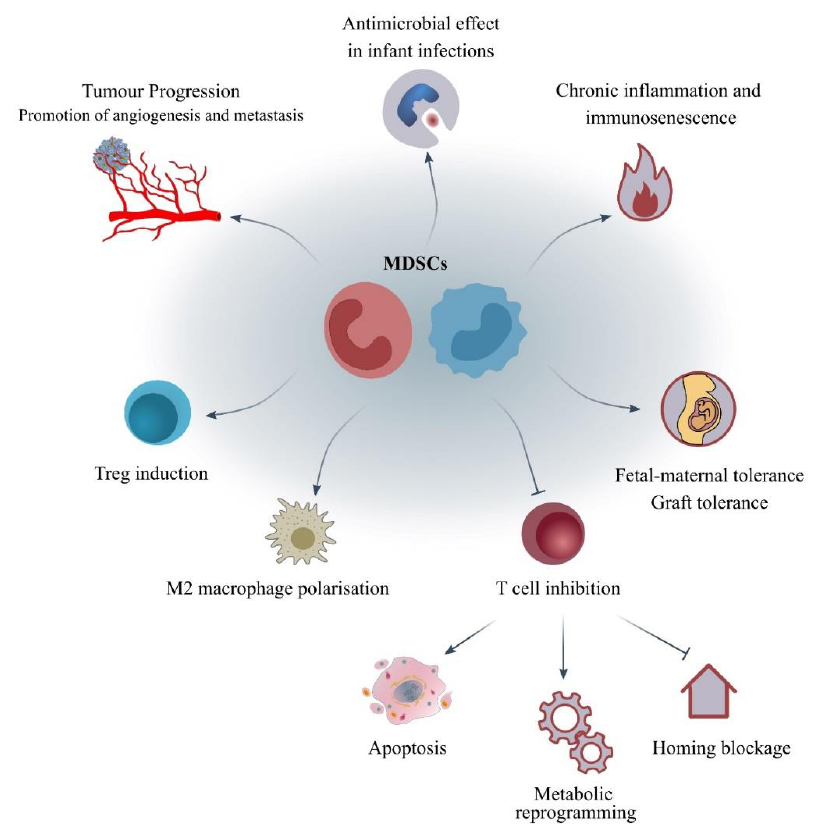
Figure 2. Mechanisms of action of MDSCs. MDSCs are thought to be cells with immune-modulatory properties. These cells are thought to be elevated and play an important role in chronic inflammation, tumour progression, and immunosenescence. They act through several mechanisms such as inhibition of T-cell responses, induction of T-regs, M2 macrophage polarisation, etc. However, they have also beneficial roles such as in foetal–maternal tolerance and during infant infections.